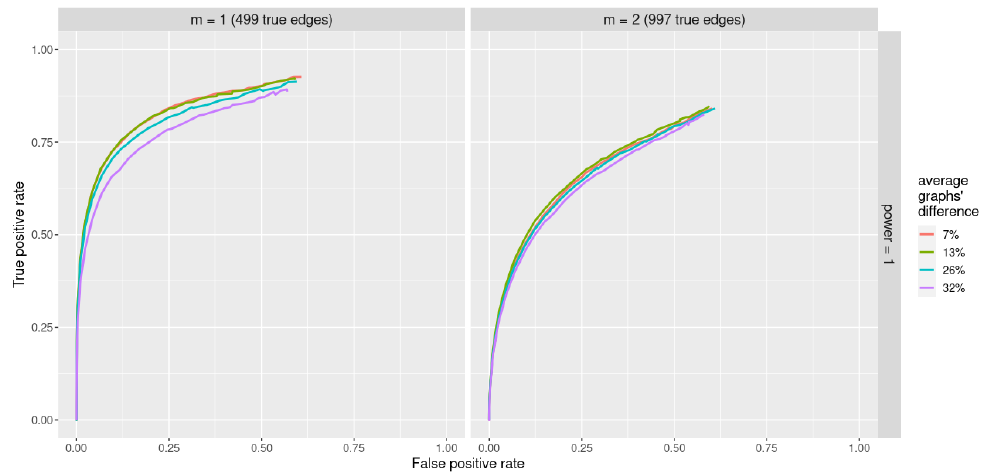
Figure 4. ROC curves for jewel 2.0 method applied to K = 3 datasets of the size p = 500, n k = 100 with various differences between their underlying graphs (denoted by different colors). Parameter ( k ) = 1. Left panel : performance for m = 1, i.e., 499 edges. power = 1, all weights are set W ij Right panel : performance for m = 2, i.e., 997